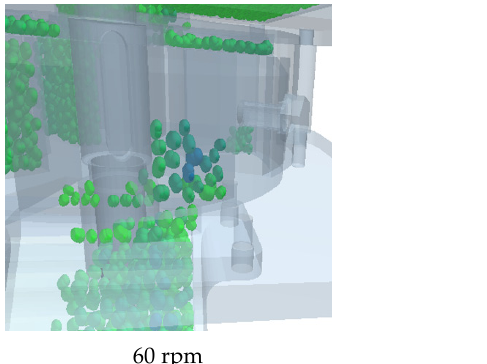
Figure 8. Top view of the collection plane.